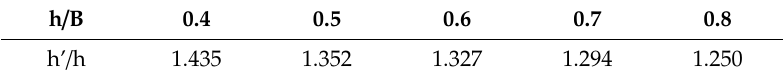
Table 6. Ratio of the initial fluid height to the maximum sloshing height according to h/B.